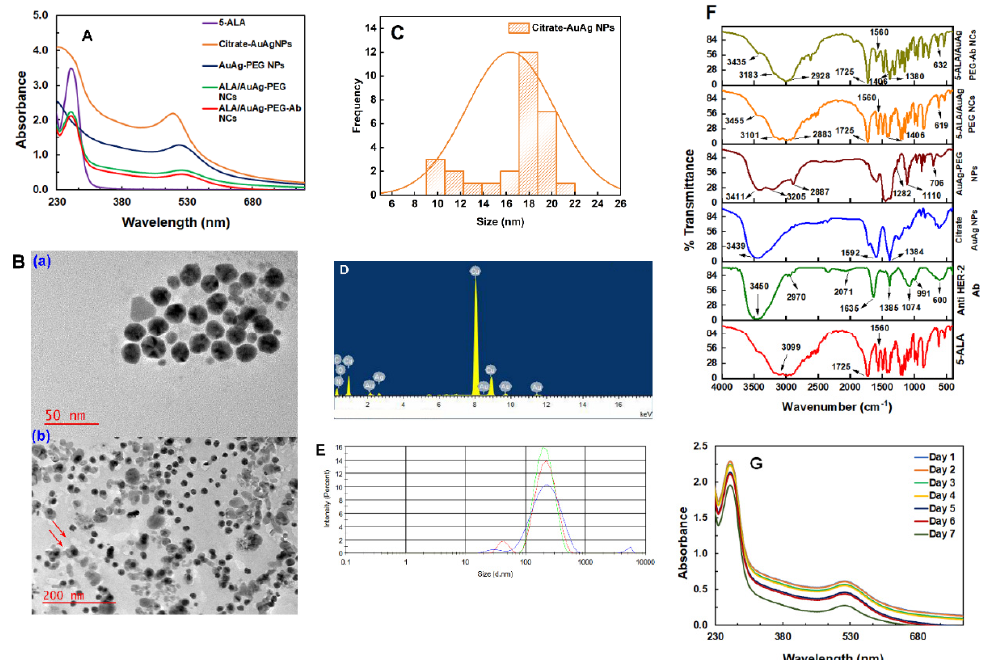
Figure 1. Characterization of the NCs. ( A ) UV-Visible spectra of 5-ALA, citrate Au–Ag NPs, 5-ALA/Au–Ag-PEG, and 5-ALA/Au–Ag-PEG-Ab NCs, ( B ) TEM images of ( a ) citrate Au–Ag NPs and ( b ) 5-ALA/Au–Ag-PEG-Ab NCs, ( C ) Particle size distribution of citrate Au–Ag NPs, ( D ) EDS spectra of 5-ALA/Au–Ag-PEG-Ab NCs, ( E ) Hydrodynamic size of 5- ALA/Au–Ag-PEG-Ab NCs by DLS, ( F ) FT-IR spectra of 5-ALA, anti HER-2 Ab, citrate Au–Ag NPs, Au–Ag-PEG NPs, 5-ALA/Au–Ag-PEG NCs, and 5-ALA/Au–Ag-PEG-Ab NCs, ( G ) photostability of 5-ALA/Au–Ag-PEG-Ab NCs in PBS over 7